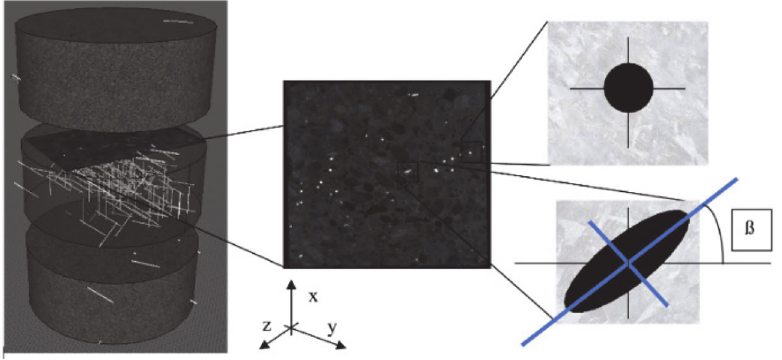
Figure 4. Randomly inserted surface into a space – a